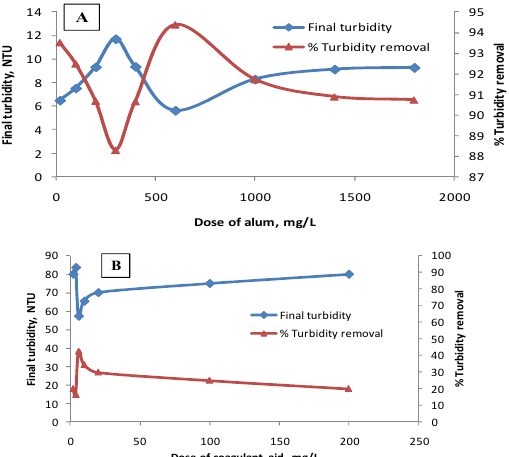
Fig.2. Effect of coagulant or coagulant aid doses on removal of turbidity; A: alum, B: